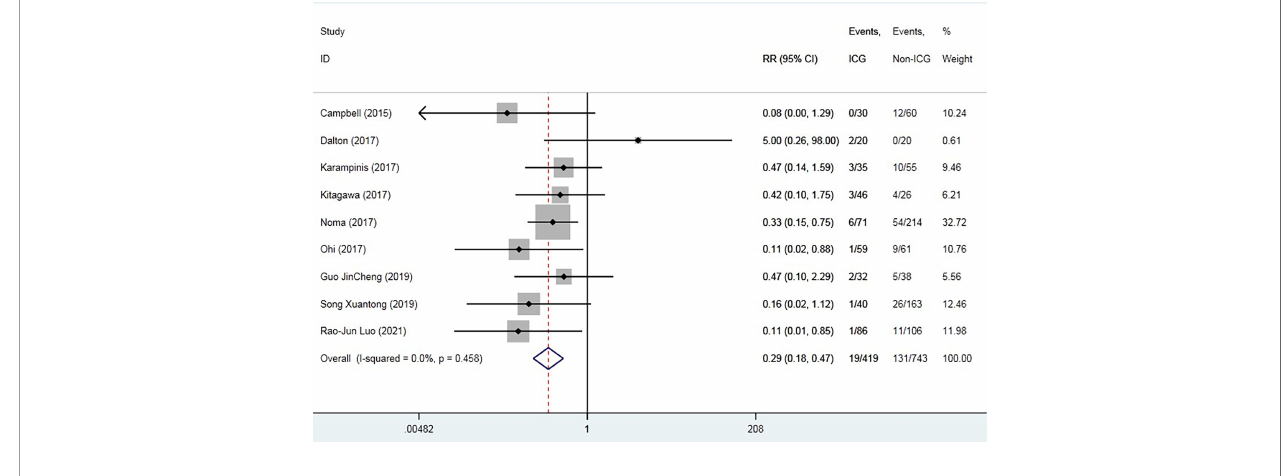
FIGURE 2 | Forest plot for anastomotic leak.